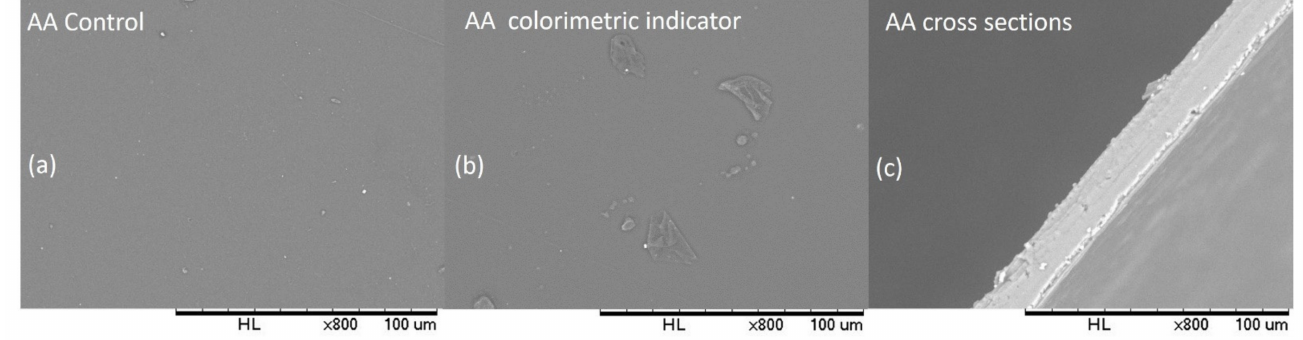
Figure 5. SEM of the AA sensors. ( a ) Film control, ( b ) AA indicator colorimetric and ( c ) cross sections. The left micrograph shows the surface of the sensors and the right micrograph illustrates the film cross section. All magnifications are 800 ×